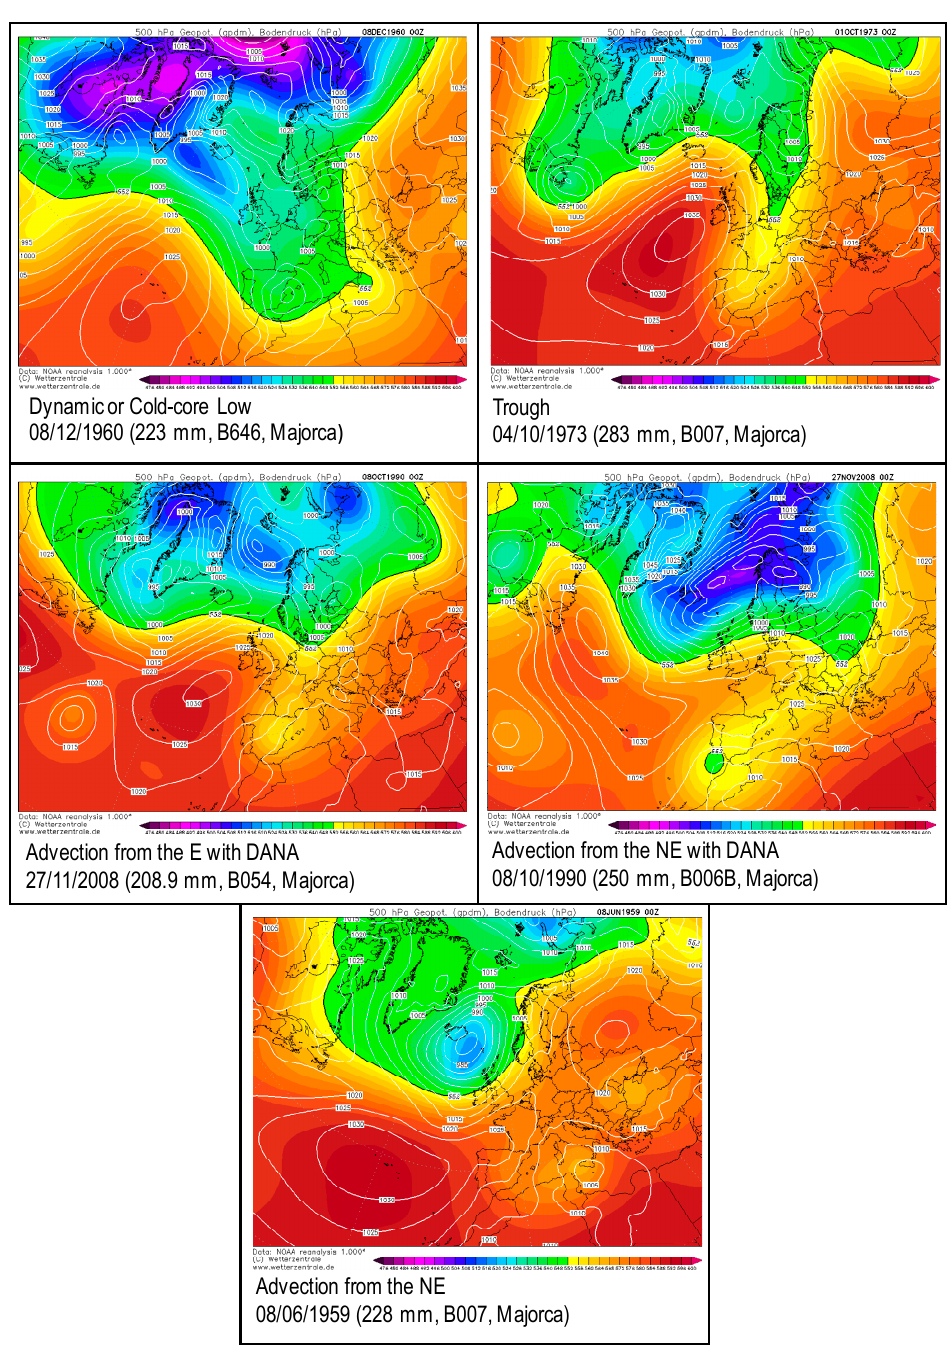
Figure 4. Representative examples of different synoptic situations on days with over 200 mm of rainfall in the Balearic Islands. Source: www.wetterzentrale.de (accessed on 10 August